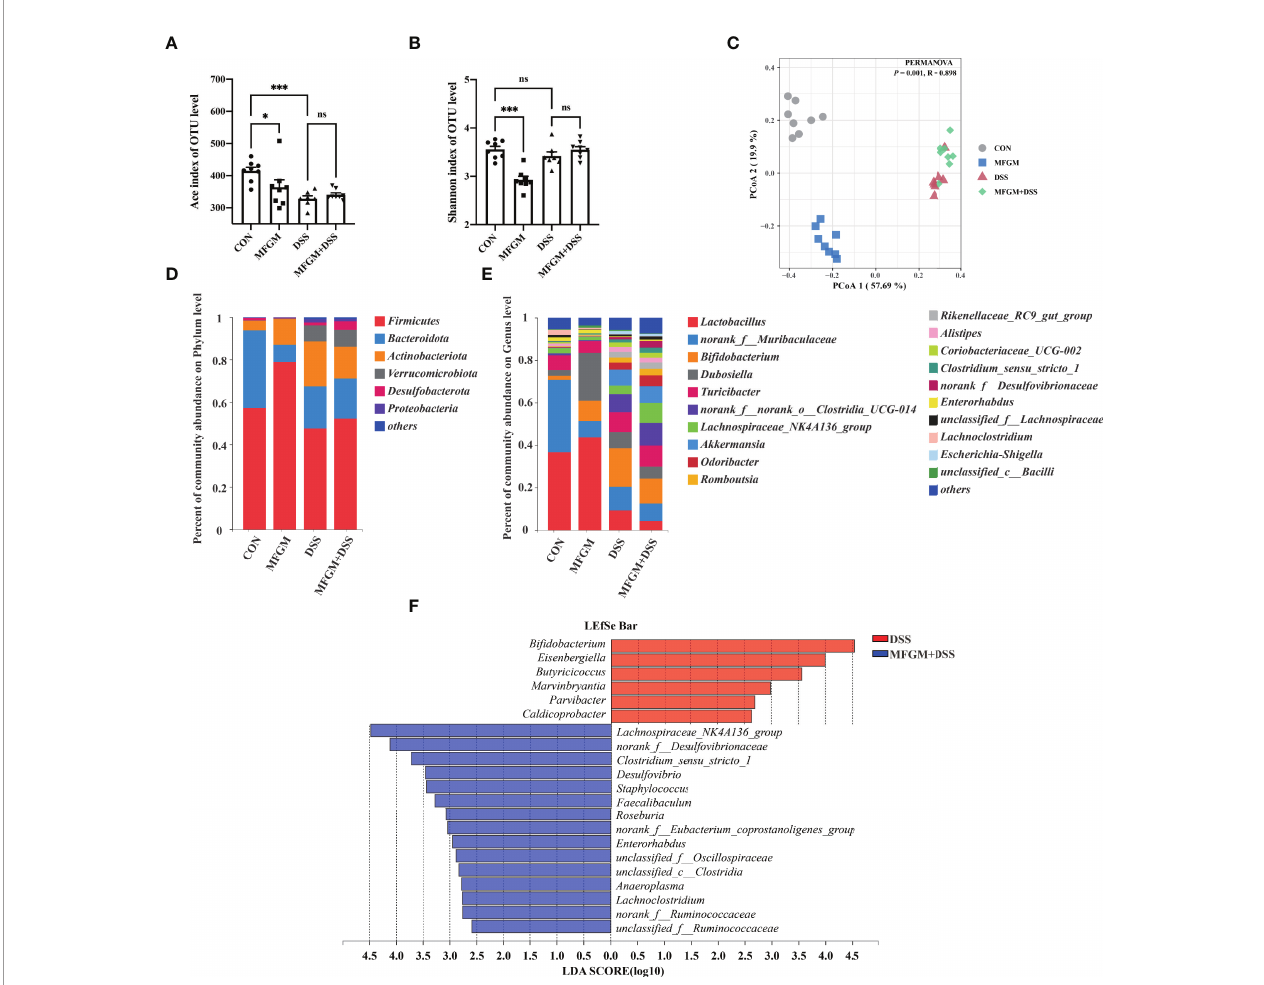
FIGURE 3 | Milk fat globule membrane (MFGM) regulated the composition and structure of intestinal microbiota. a -Diversity upon oral therapy represented by the Ace index (A) and Shannon index (B) . (C) Principal coordinate analysis plots upon dextran sulfate sodium (DSS) treatment. The relative abundance of fecal bacterial phyla (D) and genera (E) presented in 99.5% of the community upon DSS treatment. (F) Analysis of differences in the microbial taxa shown by linear discriminant analysis coupled with effect size measurements upon DSS treatment. Data were presented as means ± SEM ( n = 6 – 8 per group). Statistical signi fi cance was determined using one-way ANOVA, followed by Tukey ’ s test. ns, no signi fi cant, *P ≤ 0.05, ***P ≤